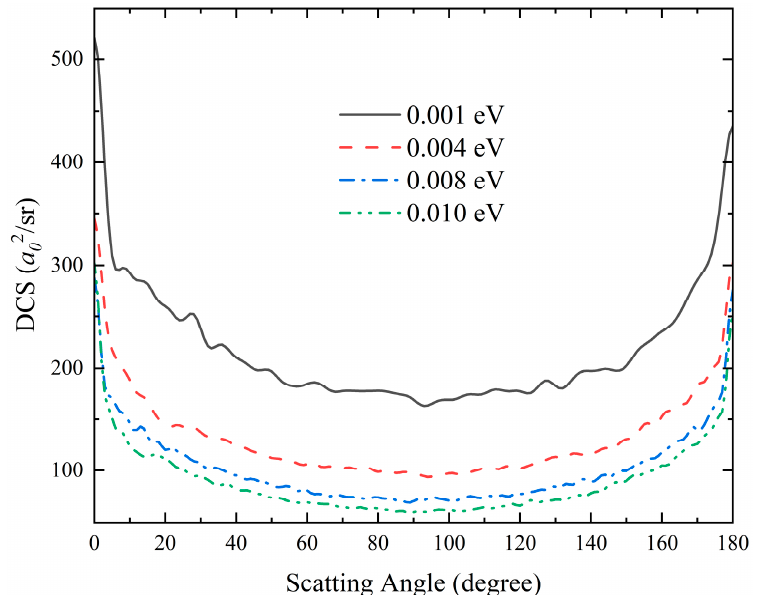
Figure 9. Total DCSs of the product LiNa molecules of the Li( 2 S) + Na 2 ( v = 0, j = 0) → LiNa + Na reaction at four collision energies (0.001, 0.004, 0.008 and 0.010 eV) as a function of scattering angle calculated by the improved TDWP method on the GP PES.